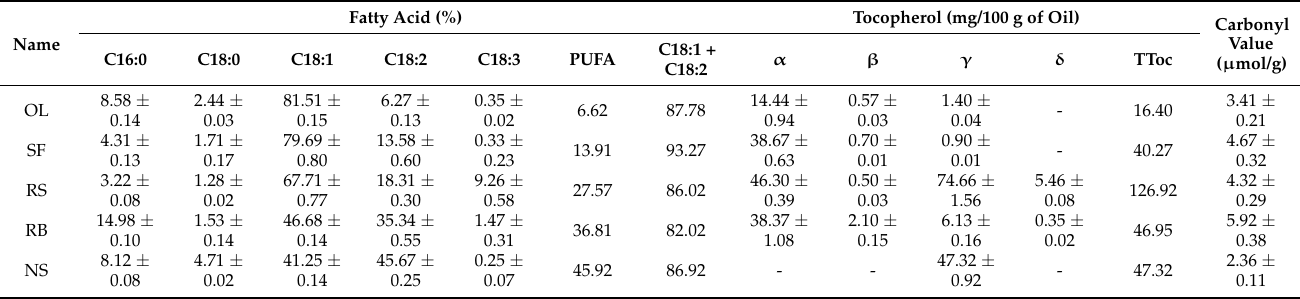
Table 1. Fatty acid and tocopherol compositions, and carbonyl values of samples of 10 types of oil before frying. Reprinted/adapted with permission from Ref. [21]. Copyright 2020,